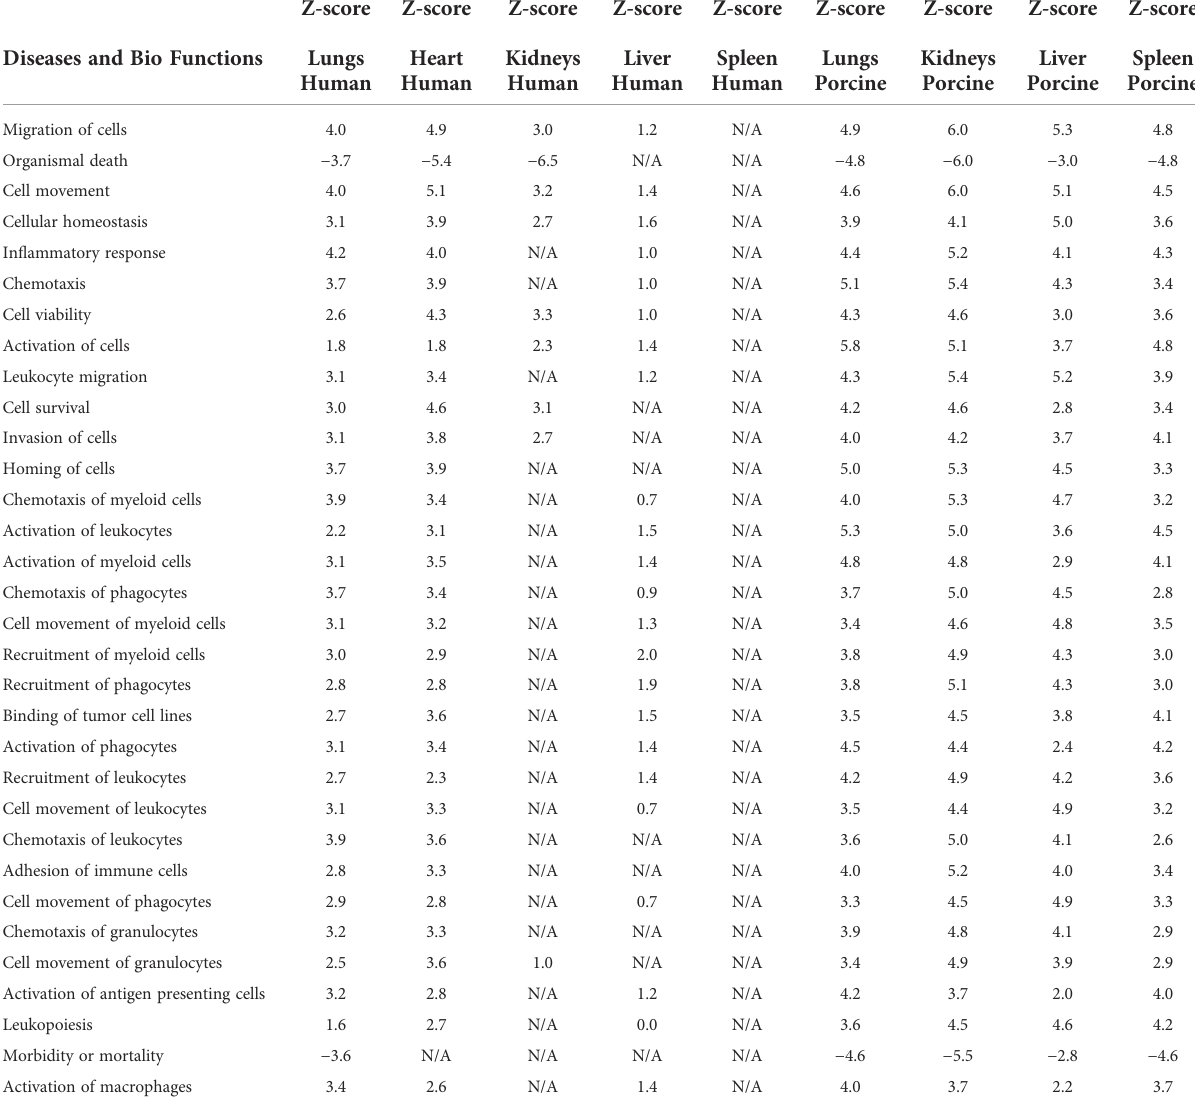
TABLE 4 Predicted biofunctions based on Z-score values in FFPE tissue samples from patients with meningococcal septic shock and in organs from porcinis infused with exponentially increasing numbers of N. meningitidis (reference strain H44/76) vs.